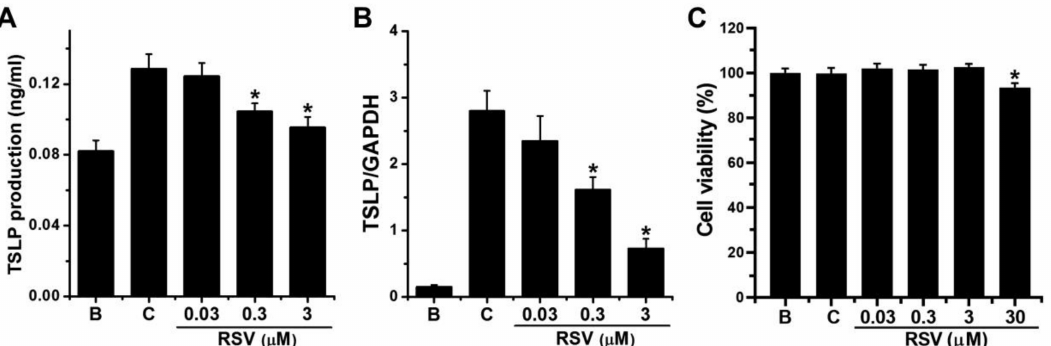
Figure 2. Effects of RSV on the production and mRNA expression of TSLP. ( A ) TSLP production was analyzed with ELISA. ( B ) TSLP mRNA expression was analyzed with real-time PCR. ( C ) Cell viability was analyzed with MTT assay. ( B ), PBS-added group; ( C ), PBS plus PMACI-added group. * indicates p < 0.05 versus the control (PBS plus PMACI)